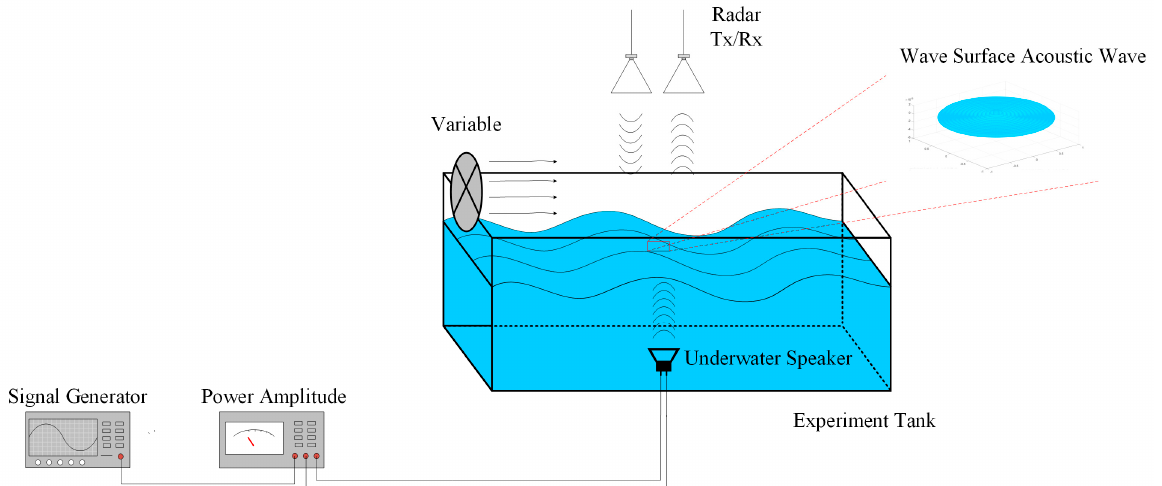
Figure 3. Schematic diagram of the experimental system.